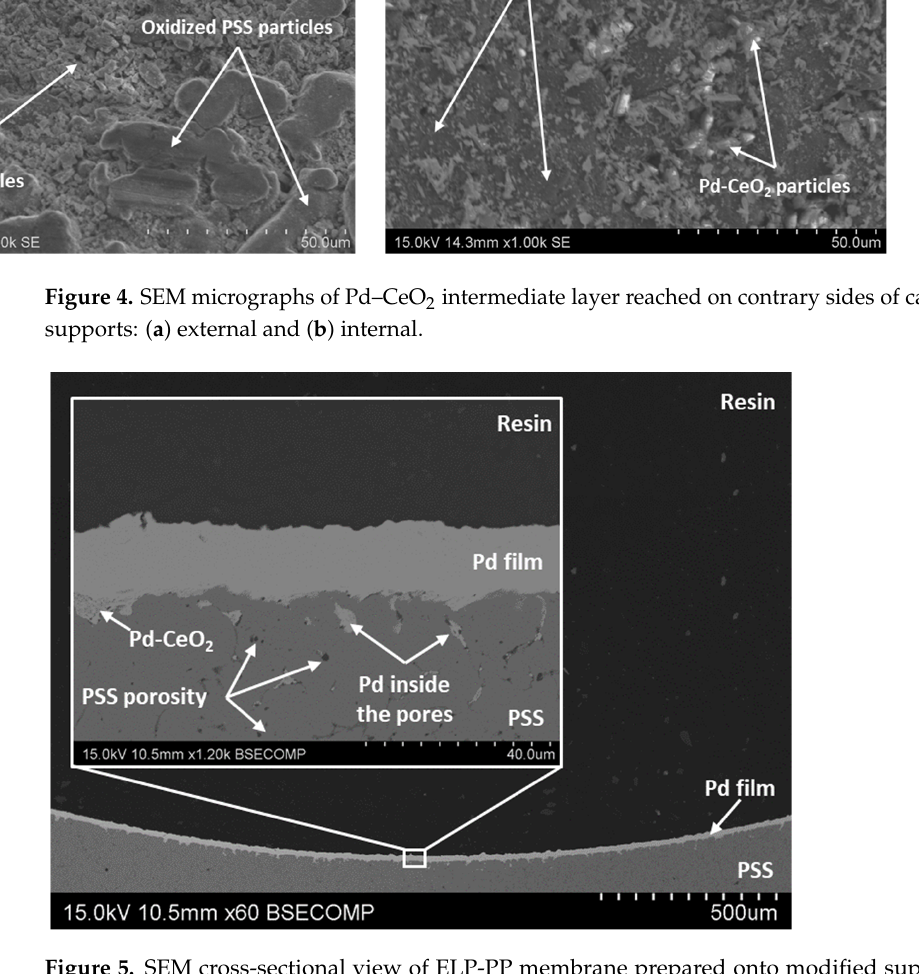
Figure 5. SEM cross ‐ sectional view of ELP ‐ PP membrane prepared onto modified supports with Figure 5. SEM cross-sectional view of ELP-PP membrane prepared onto modified supports with doped CeO 2 intermediate layer. doped CeO 2 intermediate